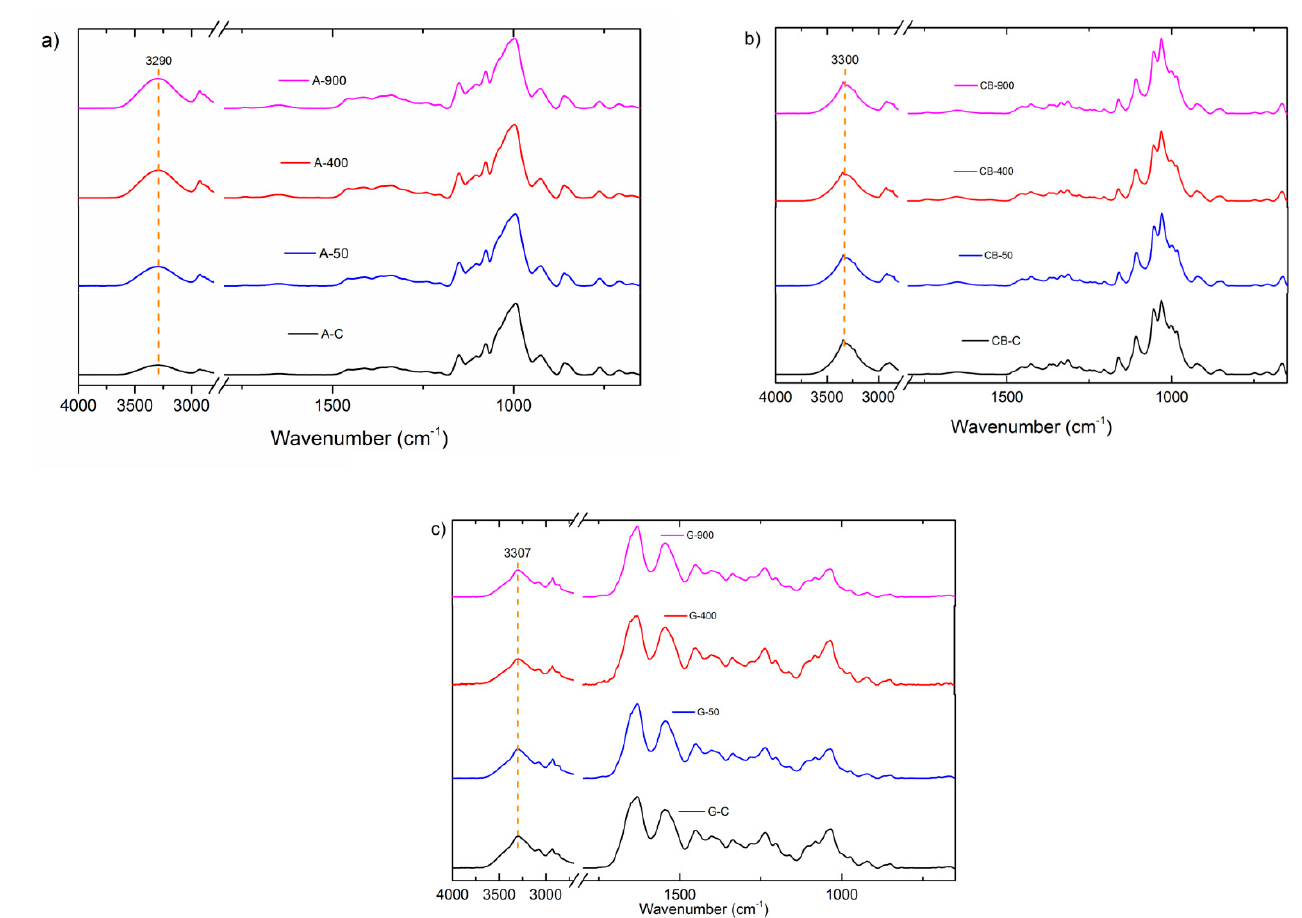
Figure 1. FTIR spectra of ( a ) starch films, ( b ) bacterial cellulose films, and ( c ) gelatin films subjected to plasma treatment.